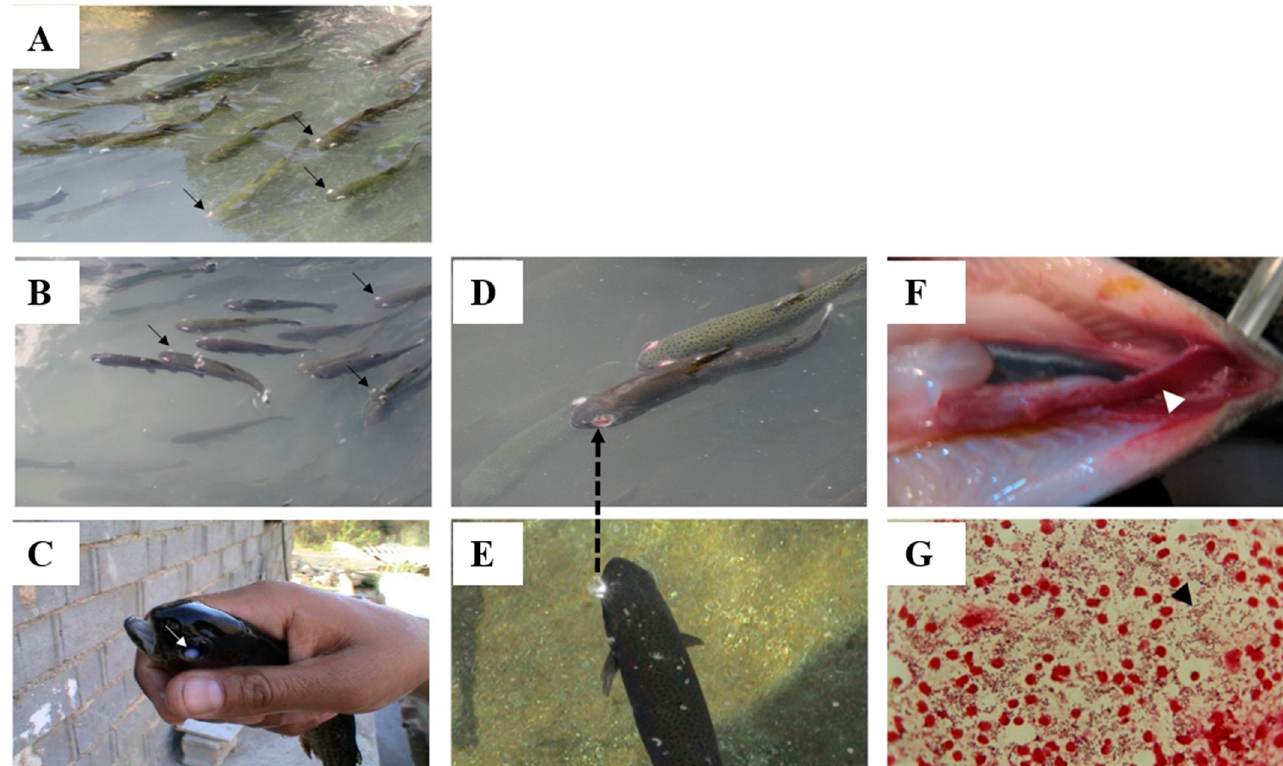
Figure 1. Rainbow trout growing in race ways and affected by L. garvieae showing: ( A ) typical bilateral exophthalmia and no change in the color skin, ( B ) typical bilateral exophthalmia and beginning of skin color change, ( C ) typical cataract and dark color, ( D ) bilateral exophthalmia and a complete loss of the eye, ( E ) darkening of body and an explosion of the eye, and ( F ) hemorrhage of intestine, ( G ) direct Gram stain preparation of spleen of diseased fish showing huge numbers of Gram-positive coccoid cells confirmed as L. garvieae by phenotyping and molecular works. (photos by Professor Mehdi Soltani).